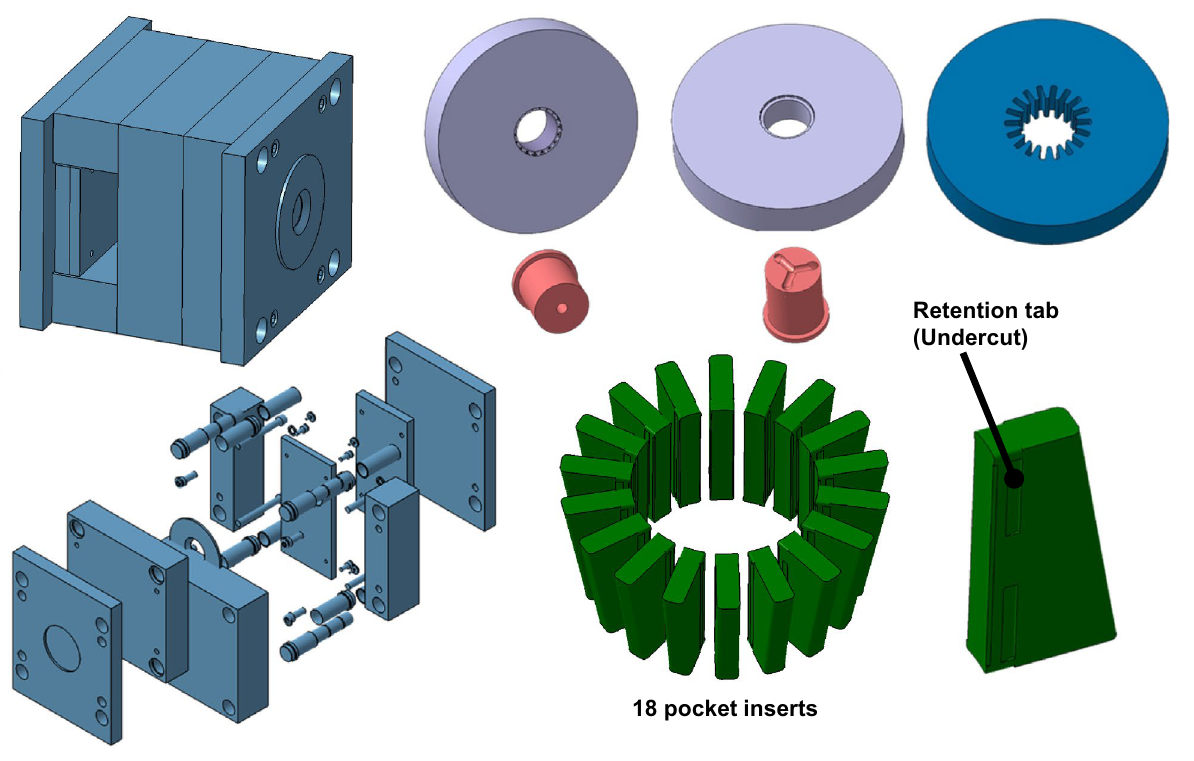
Figure 3. The specialized injection mold and its main parts (the models were not presented on the same scale).